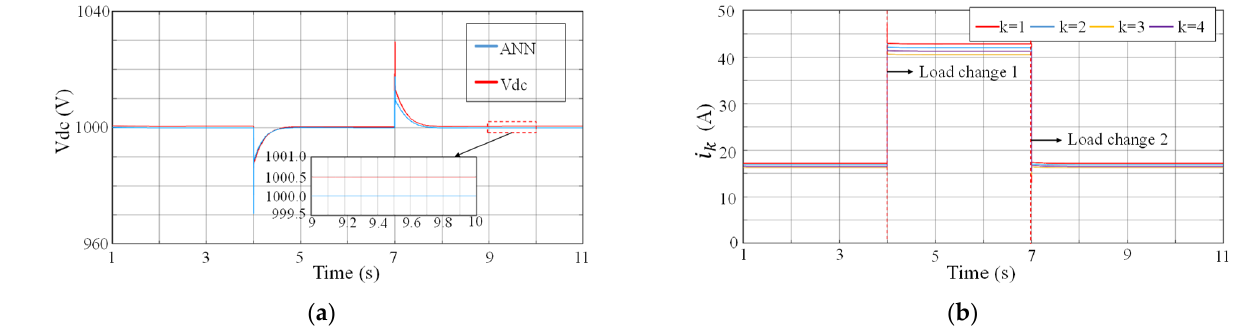
Figure 6. ( a ) Values of DC bus voltage and ANN output in case study 2; ( b ) Values of currents of the bidirectional DC ‐ DC converters in case study 2.